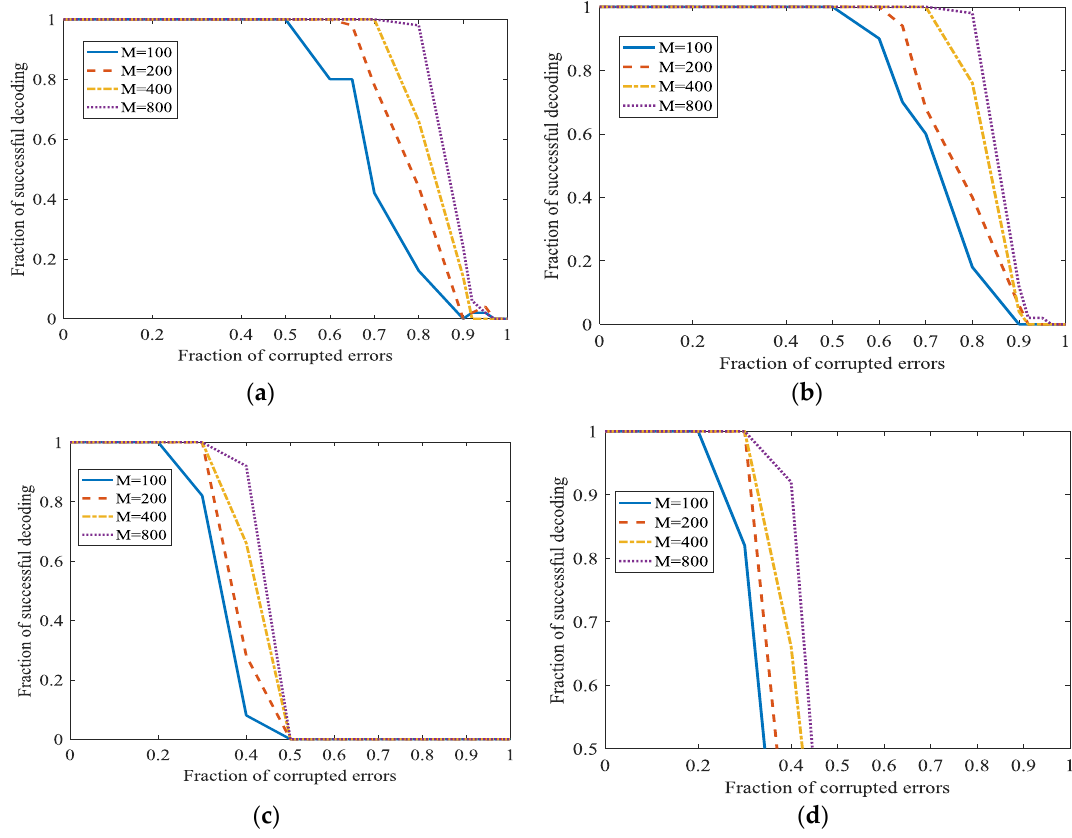
Figure 11. Error correction in L1 optimization at different m / n and (cid:107) x 0 (cid:107) . ( a ) (cid:107) x 0 (cid:107) = 1 and m / n = 3; ( b ) (cid:107) x 0 (cid:107) = 1 and m / n = 2; ( c ) (cid:107) x 0 (cid:107) = m 1/2 and m / n = 3; ( d ) (cid:107) x 0 (cid:107) = m 1/2 and m / n = In Figure 12, the secret channel is used.